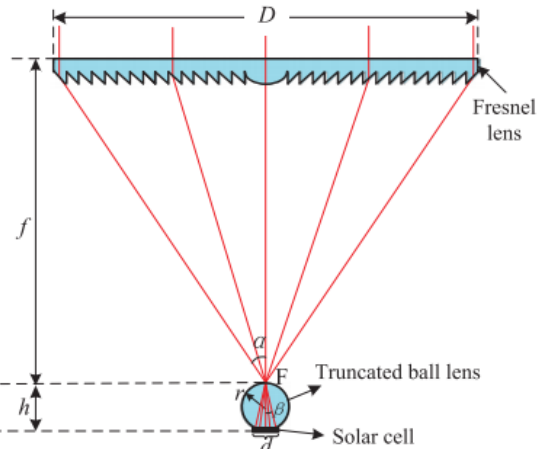
Figure 32. Concentrating optical system composed of a Fresnel lens and a ball lens [61]. Reprinted from Q. Huang et al., Design and preliminary experiments of truncated ball lens as secondary optical element for CPV system, Solar Energy 2018, 169, 19–23, with permission from Elsevier.